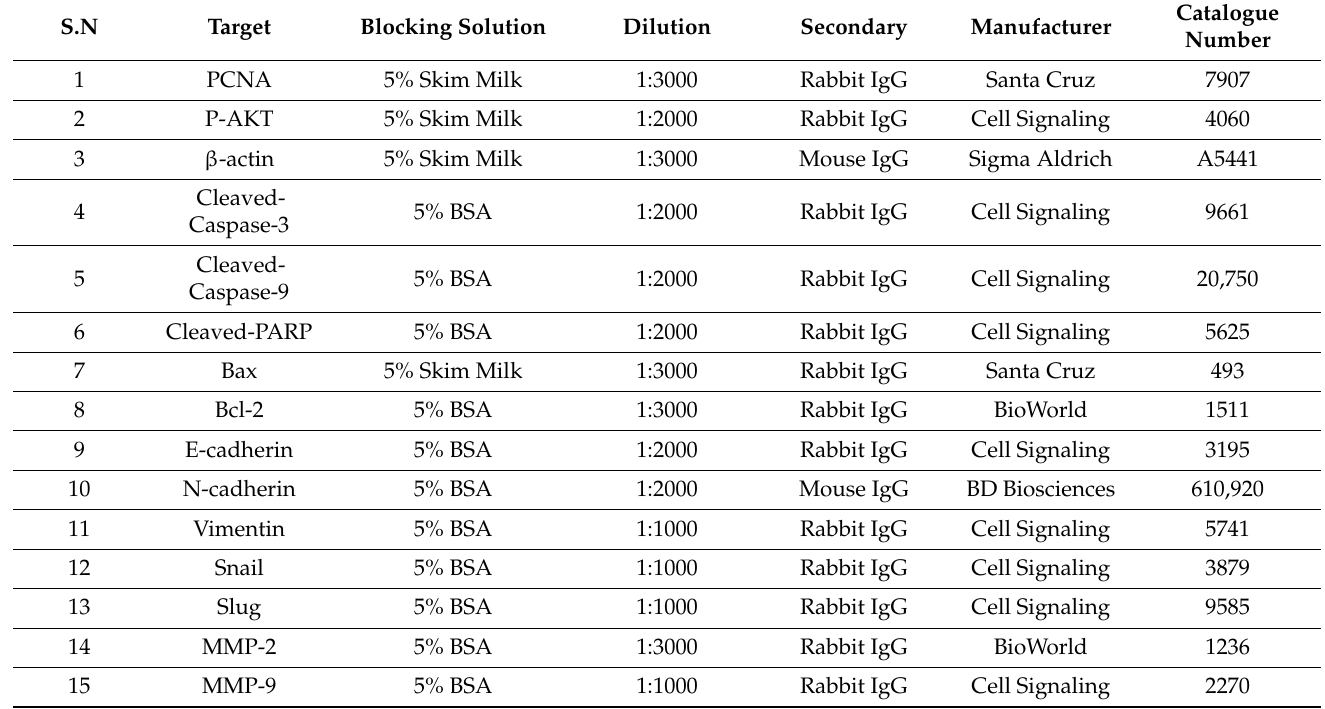
Table 1. List of specific primary antibodies and secondary antibodies used in Western blotting.